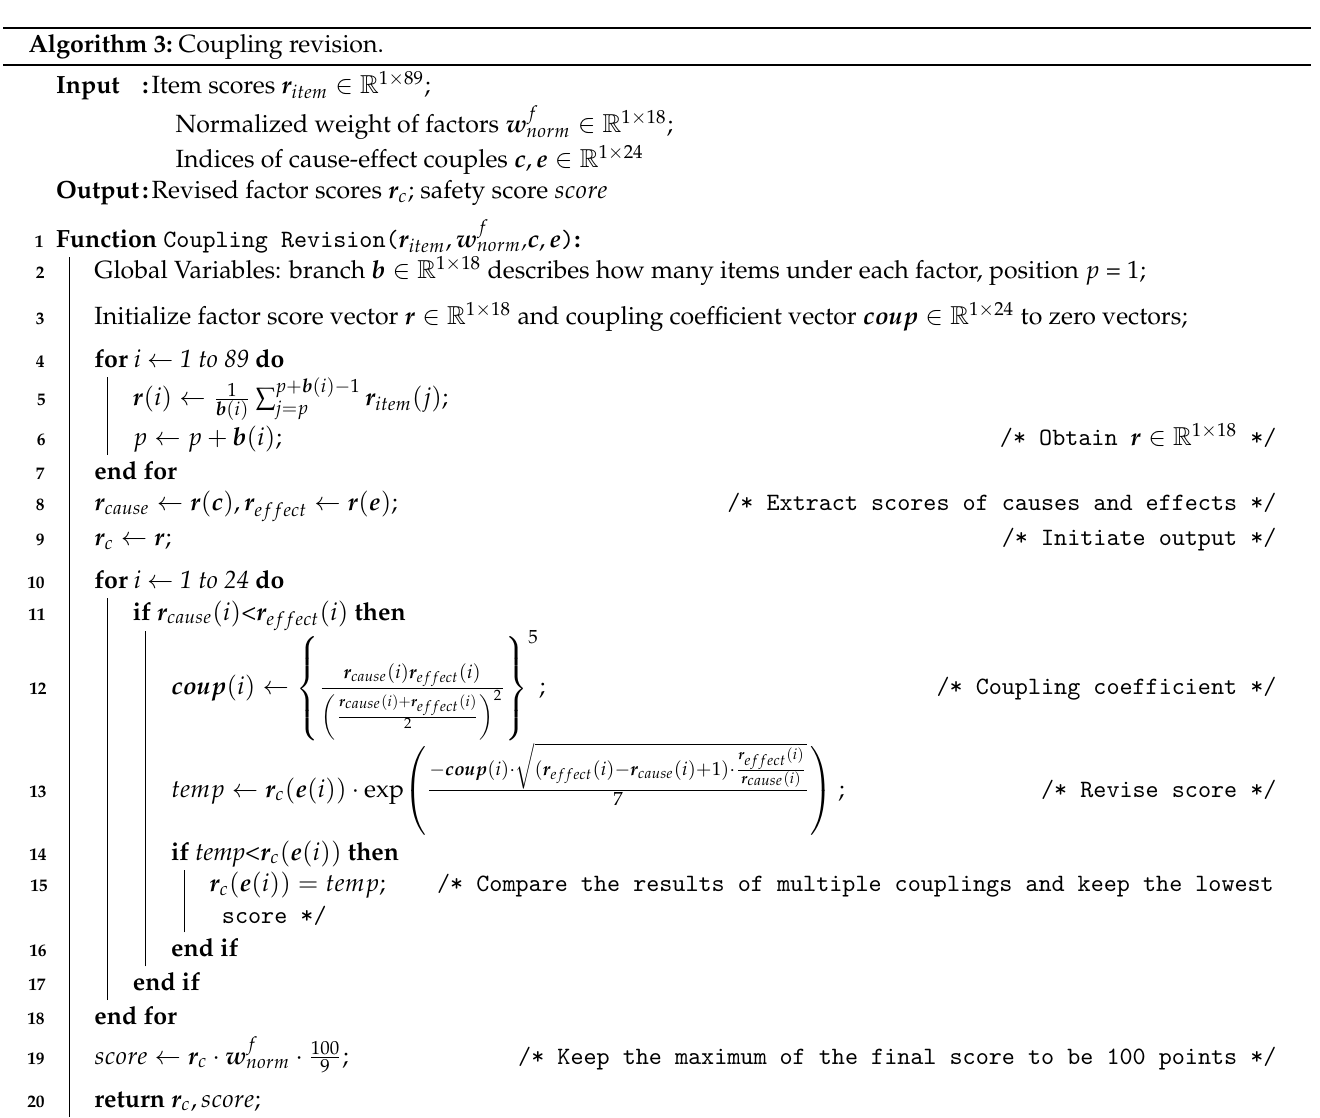
Algorithm 3: Coupling